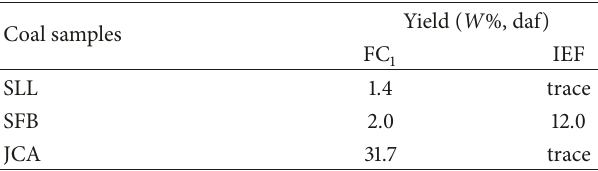
Table 2: Yields of FC 1 and IEF.